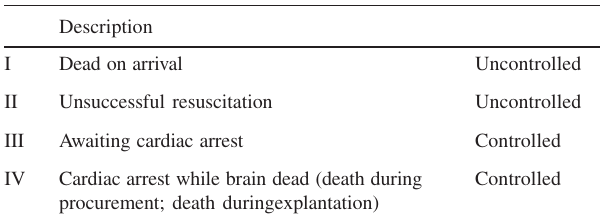
Table 1 - Non-Heart-Beating Donors - Maastricht